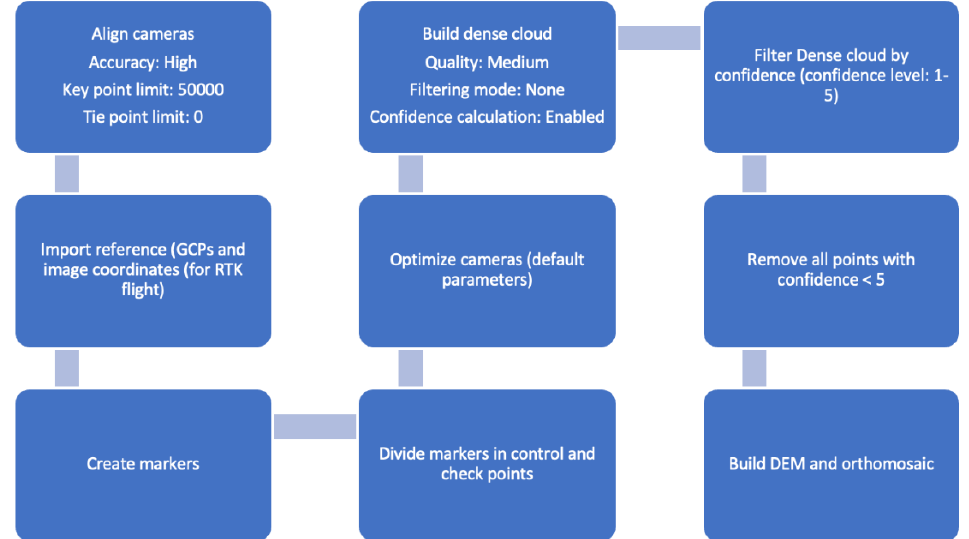
Figure 3. Photogrammetric processing workflow in Agisoft Metashape.